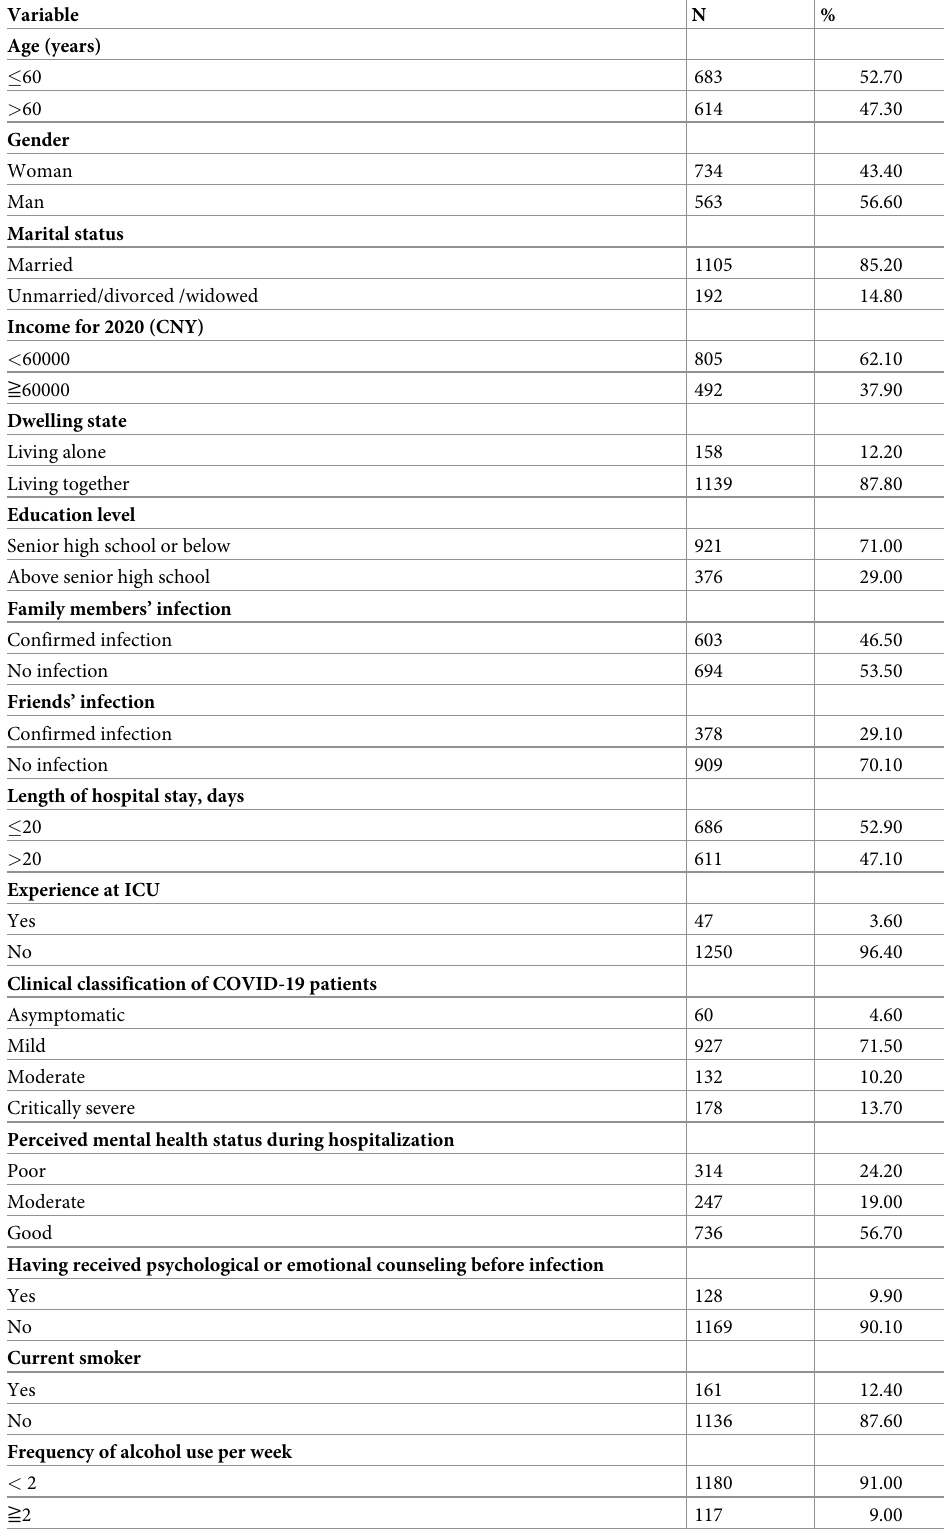
Table 1. Demographic and clinical characteristics of